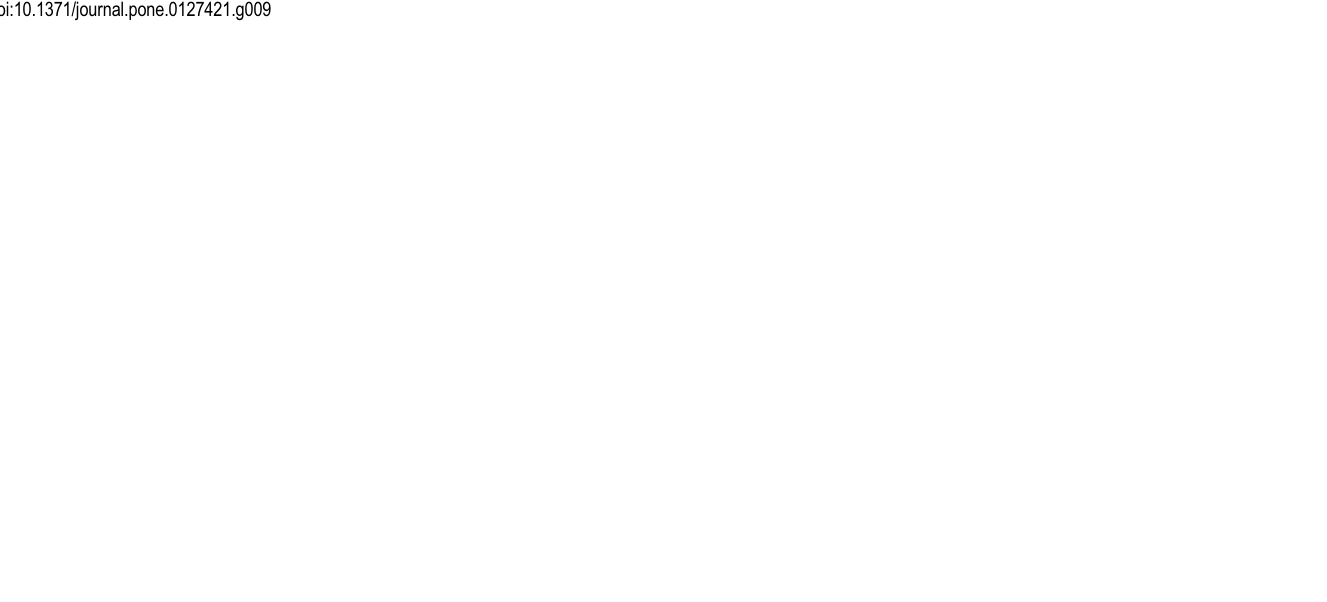
PLOS ONE | DOI:10.1371/journal.pone.0127421 May 26,